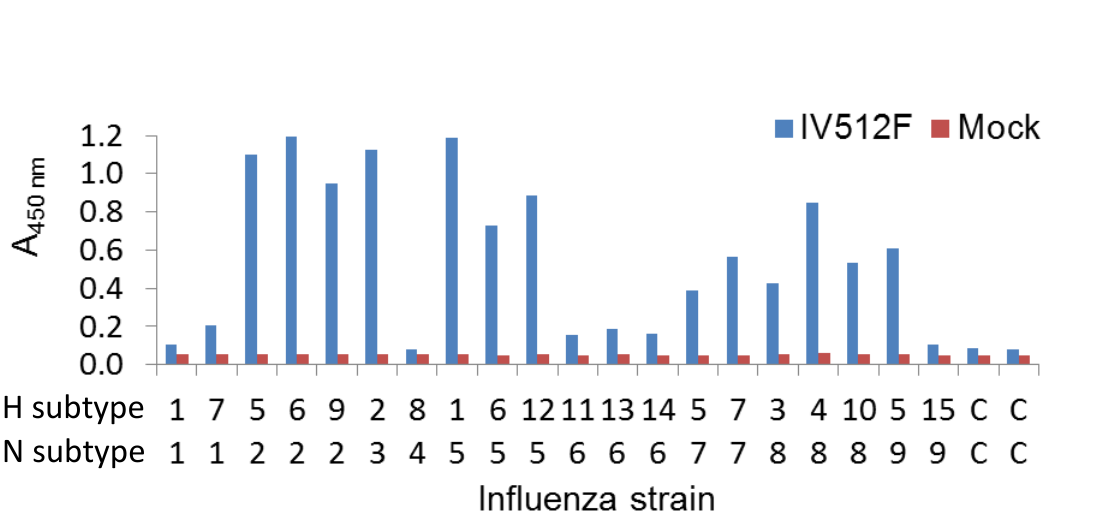
Figure 3. Cross-reaction of IV512F to NAs of different subtypes in sandwich ELISA. Plates were coated with or without (Mock) IV512F and incubated with Triton X-100 solubilized viruses of different subtypes. C indicates control incubation without influenza virus. Bound NA was subsequently detected using different biotinylated VHHs recognizing the various NAs. The H5N9 strain used was